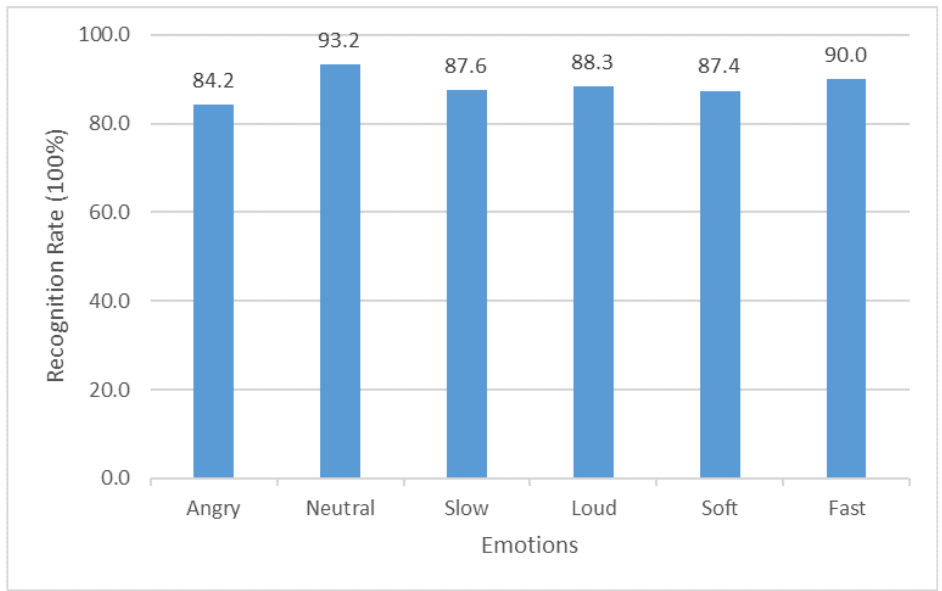
Figure 7. Emotion recognition accuracy assessment of the proposed system using SUSAS dataset.